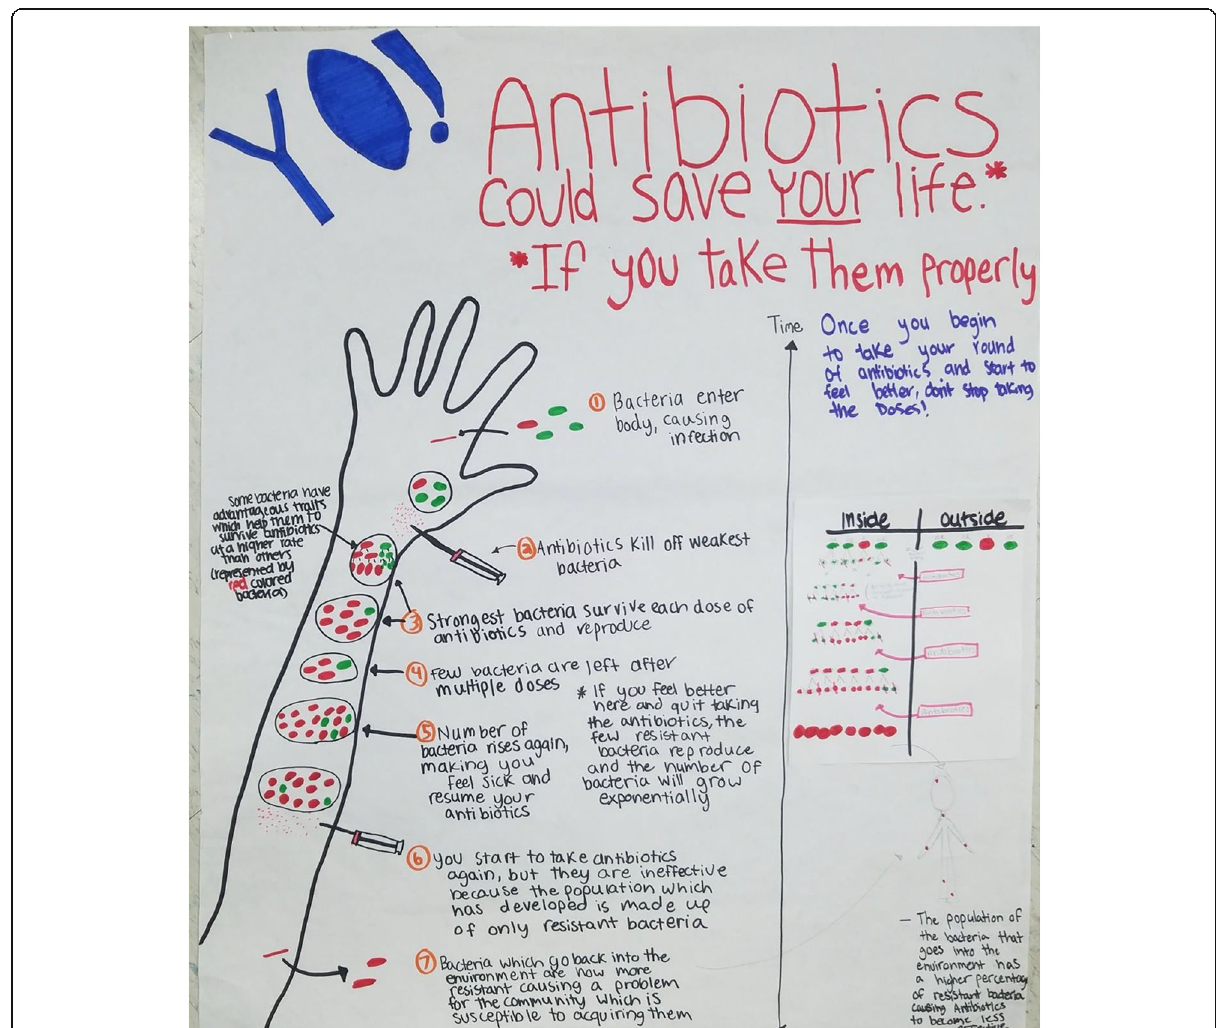
Fig. 7 A group ’ s infographic about the dangers of not taking the full dose of